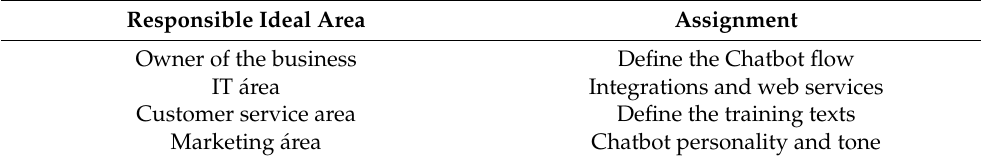
Table 1. Actors and tasks of each area involved in the Chatbot implementation